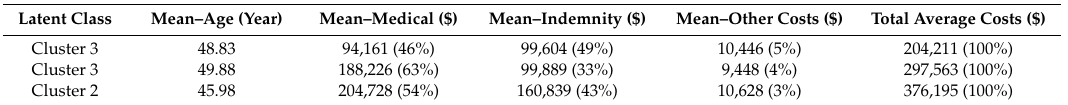
Table 11. Average cost by